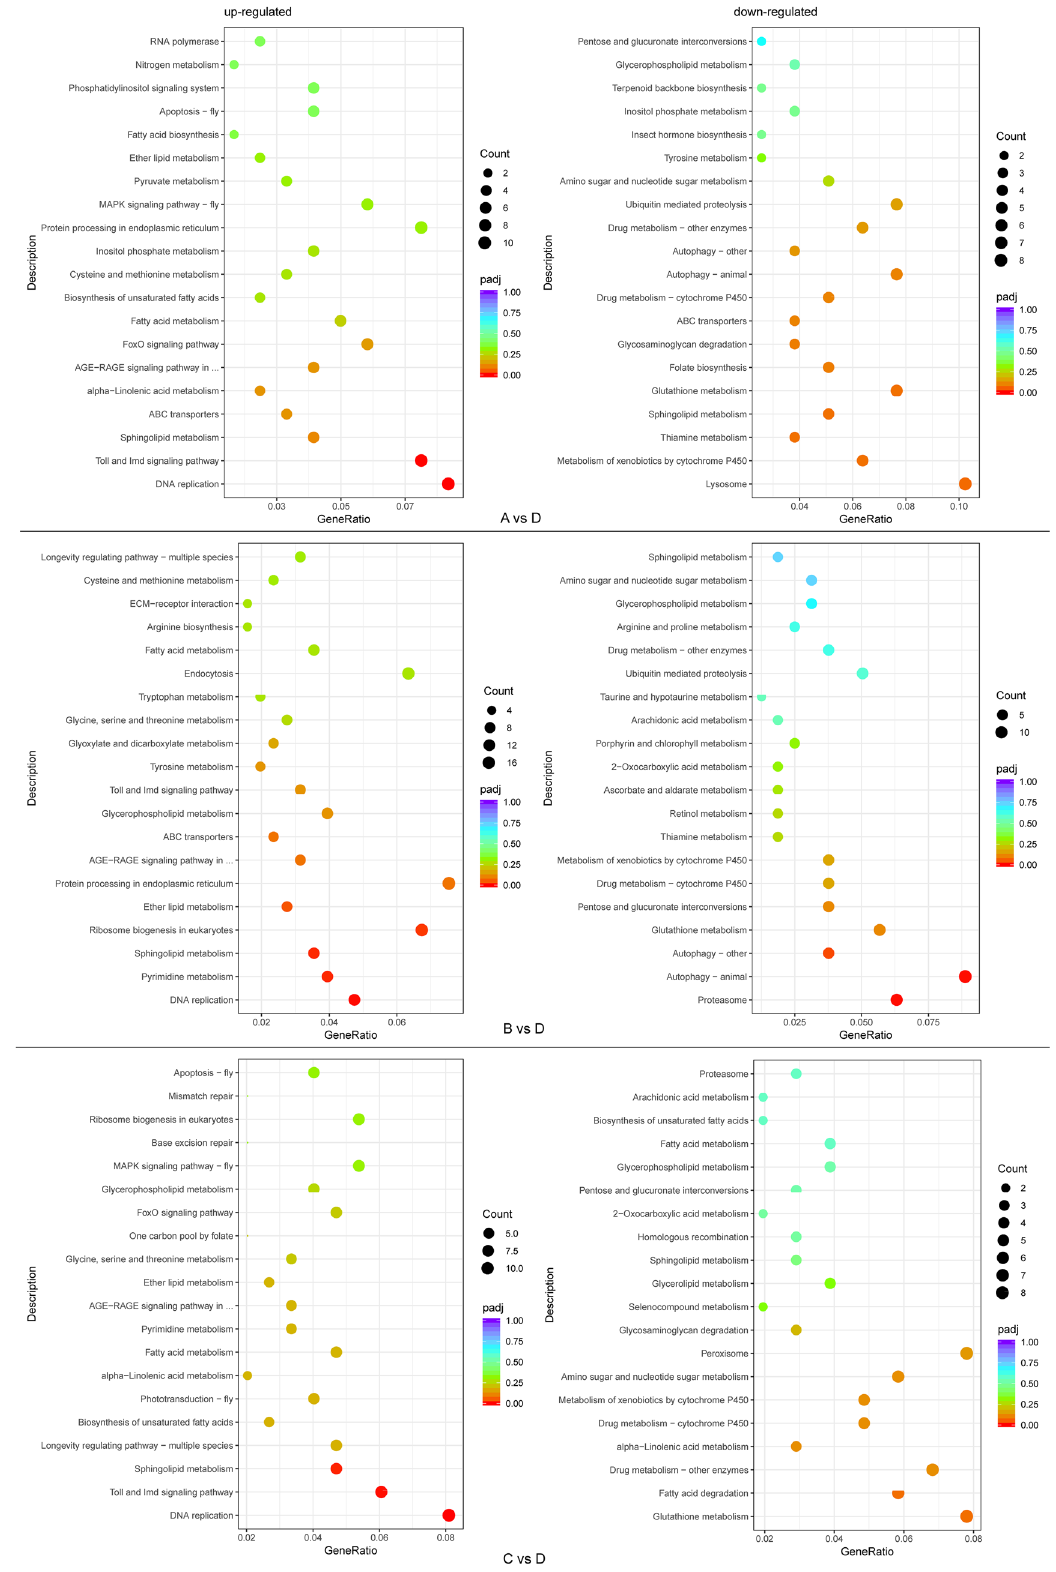
Figure 7. KEGG pathway enrichment analysis of up- and down-regulated